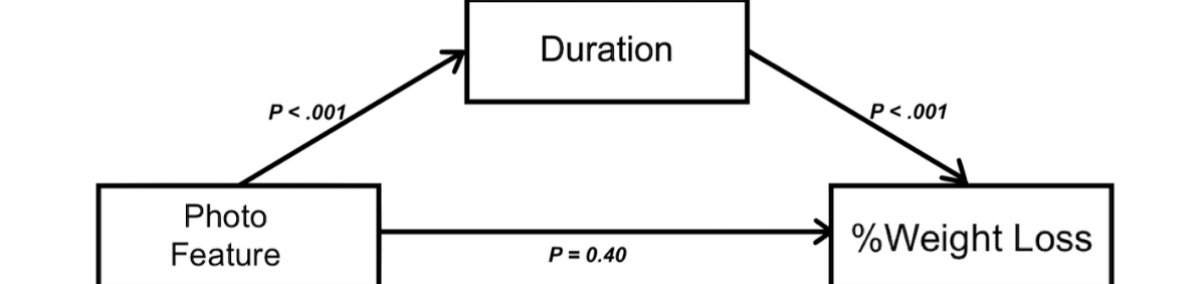
Figure 3. Duration as a mediator. The photo feature use was significantly associated (P<.001) with weight loss before adding the potential mediator, duration, as a covariate. The photo feature use was also significantly associated with duration (P<.001), and duration was significantly associated with weight loss (P<.001). When adjusting for duration, the photo feature use was no longer significantly associated with weight loss (P=0.40), indicating that duration was a